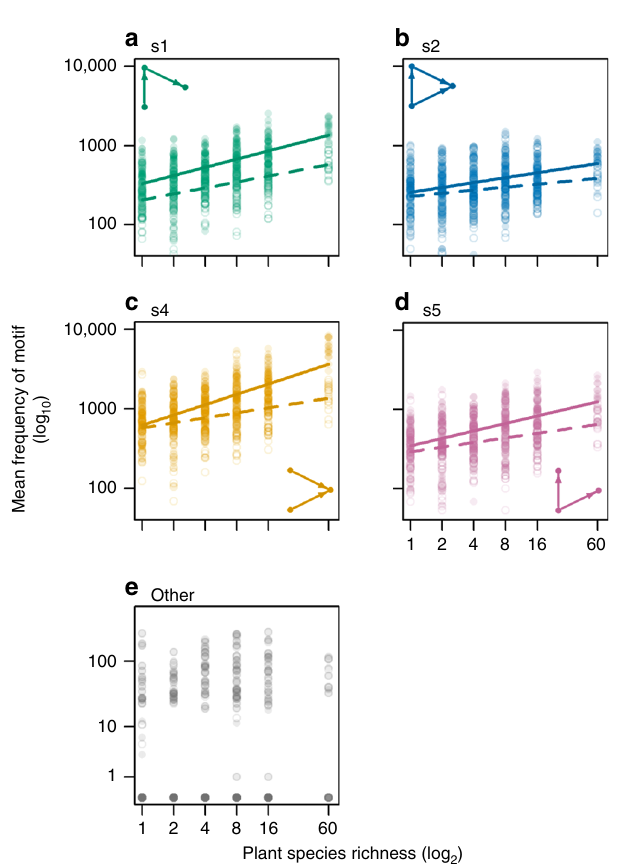
Fig. 2 Frequency of motifs in food webs. Effect of sown plant species richness on mean counts of tri-trophic chain ( a , s1), omnivory ( b , s2), apparent competition ( c , s4), exploitative competition ( d , s5) and other motifs ( e , i.e. sum of s3 and all double motif counts). Filled points and solid lines show motif frequency in the full food web, and open points and dashed lines display frequency in the consumer sub-web (i.e. free- fl oating motifs). P values from linear mixed models (two-tailed test) for the slope of all displayed relationships are <0.001 (for full model results see Supplementary Table 1). Linear models for e (other) could not be validated due to the bimodal distribution of the motif frequency